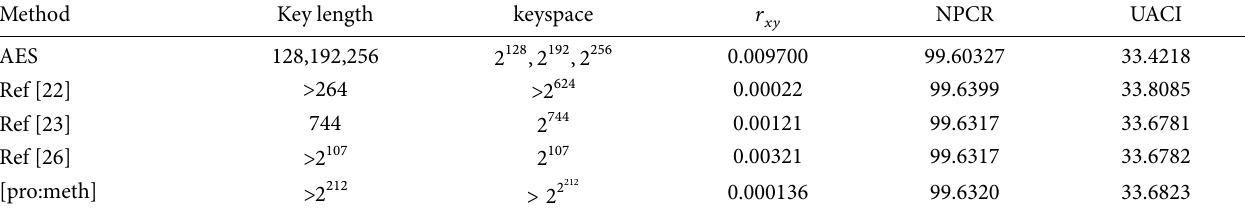
Figure 8: Key sensitivity on decryption process (a) decrypted signal with correct key, decrypted signal with incorrect key (b) Table 5: Quality metrics comparison of encryption scheme with other